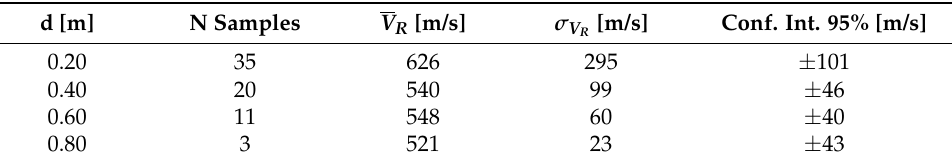
Table 2. Indirect impact tests results: distance between the measurement points d ; number of suitable samples used in the analysis; mean of R-waves velocity V R ; standard deviation of R-waves velocity σ V ; interval of R-waves velocity with a confidence level of 95%. R